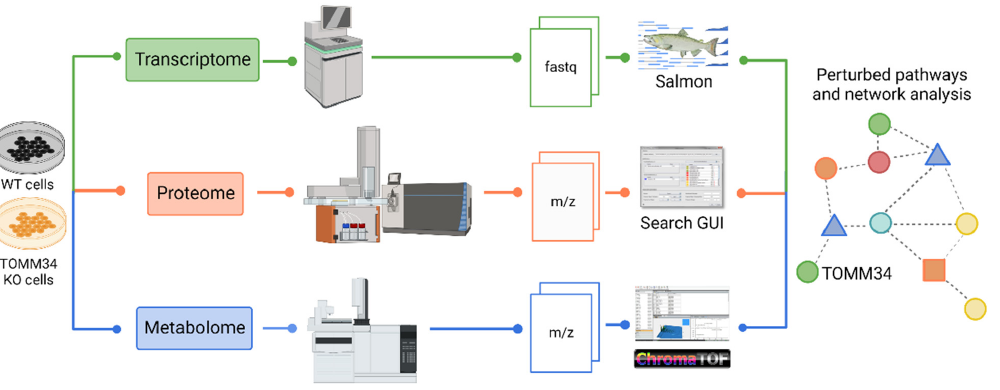
Figure 1. The overall workflow of the experiment to investigate the functional capacity of TOMM34 .